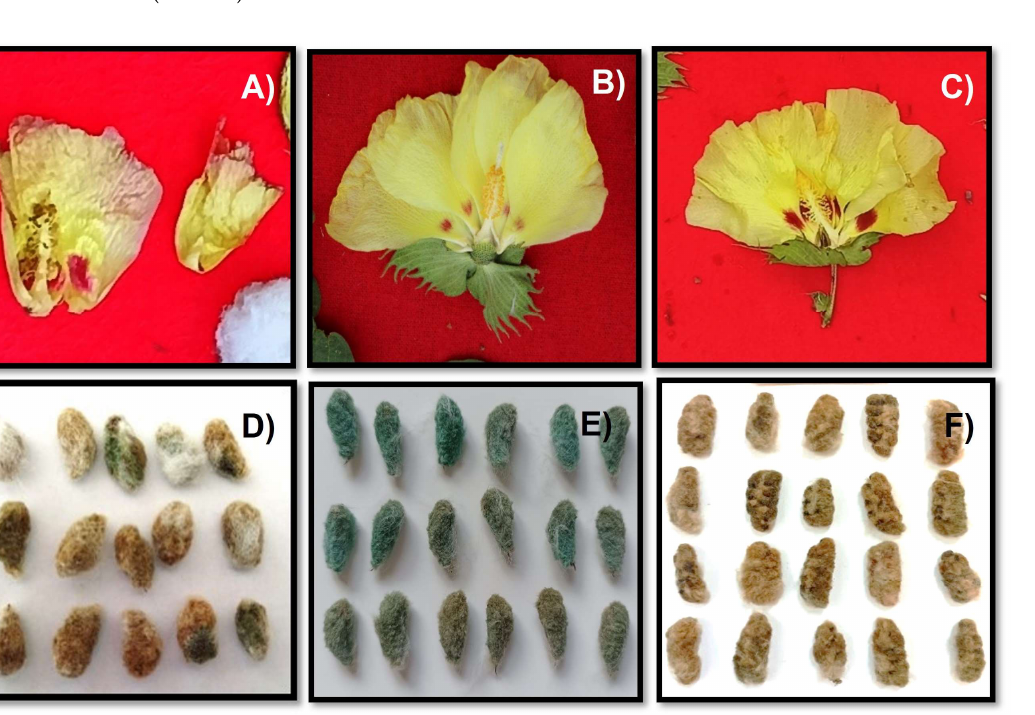
Figure 2. Details of the flowers ( A – C ) and seeds ( D – F ) of Gossypium spp. not classified in this study found in the native communities of Poyentimari ( A , D ), Koribeni ( B , E ), and Timpia ( C , F ), Cusco-Peru.